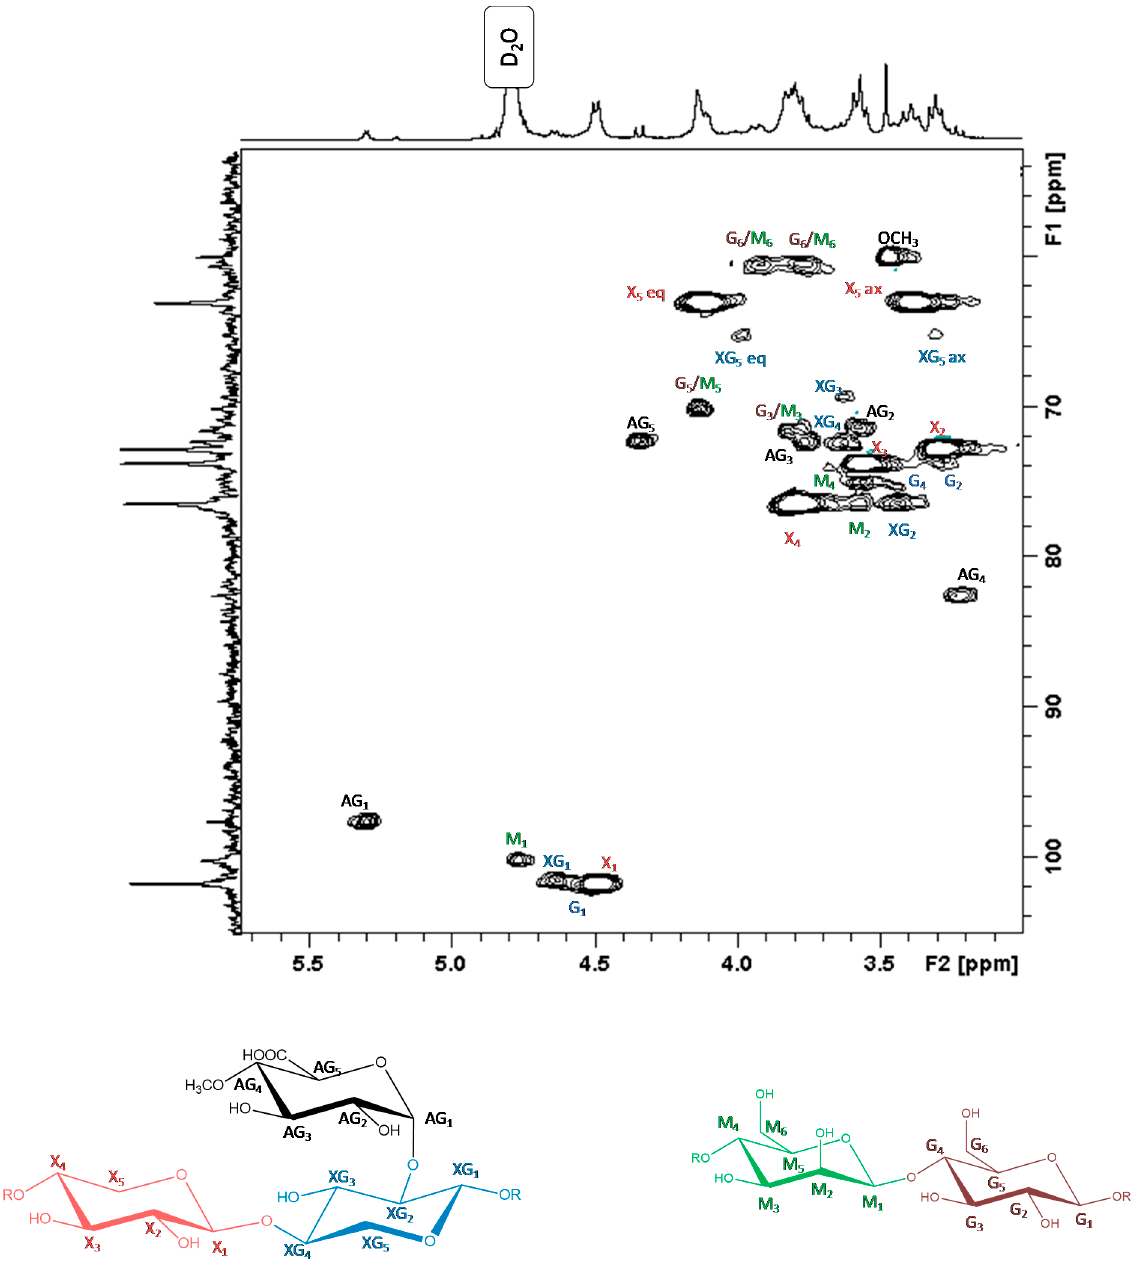
Figure 4. HSQC spectrum of hemicelluloses in D 2 O. The following designations are used: G—glucose units, M—mannose units, X—non-substituted xylose units, XG—glucuronic acid substituted xylose units, AG—glucuronic acid units. The numbers refer to the H and C atoms.